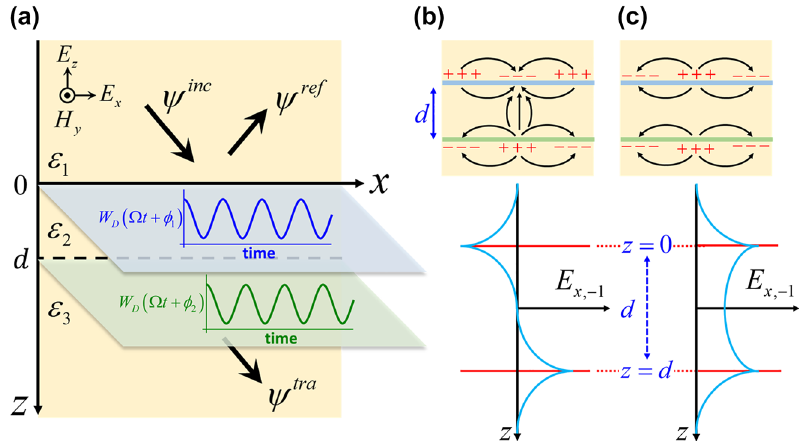
Figure 1: Schematics of the phased double- Floquet-sheet